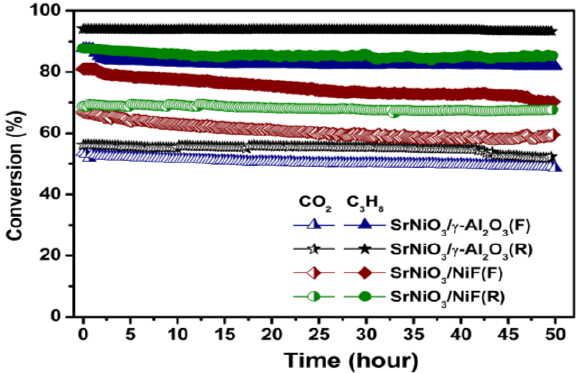
Figure 10. Stability of DRP over SrNiO 3 / γ -Al 2 O 3 (F and R) and SrNiO 3 /NiF (F and R) catalysts at 700 ◦ C, CPR = 3 (30:10:60 CO 2 :C 3 H 8 :Ar) and total flow rate = 200 mL/min for 50 h.